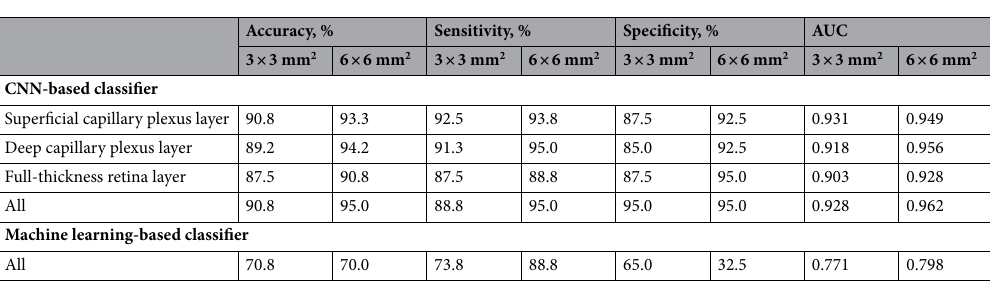
Table 2. Performance of classification task on external dataset for detecting diabetic retinopathy using the proposed deep learning- and machine learning-based classifiers. AUC area under the curve, CNN convolutional neural network, SD standard deviation.